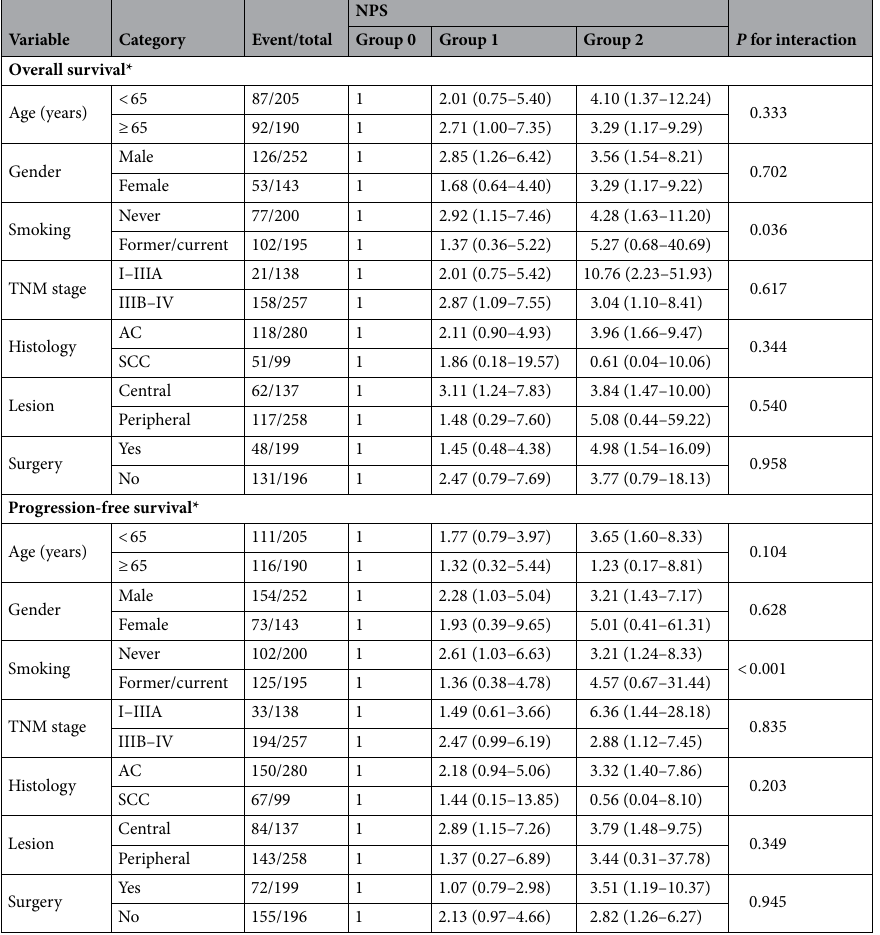
Table 5. Subgroup analysis of overall survival and progression-free survival in NSCLC patients. *Adjusted for age, gender, smoking, drinking, COPD, family history of cancer, BMI, TNM stage, histology, lesion, laterality, surgery, chemotherapy, radiotherapy, targeted therapy, CEA, NSE, albumin, total cholesterol, NLR, LMR, PNI, COUNT and SIS and the corresponding variable was removed from the models when it was a stratified